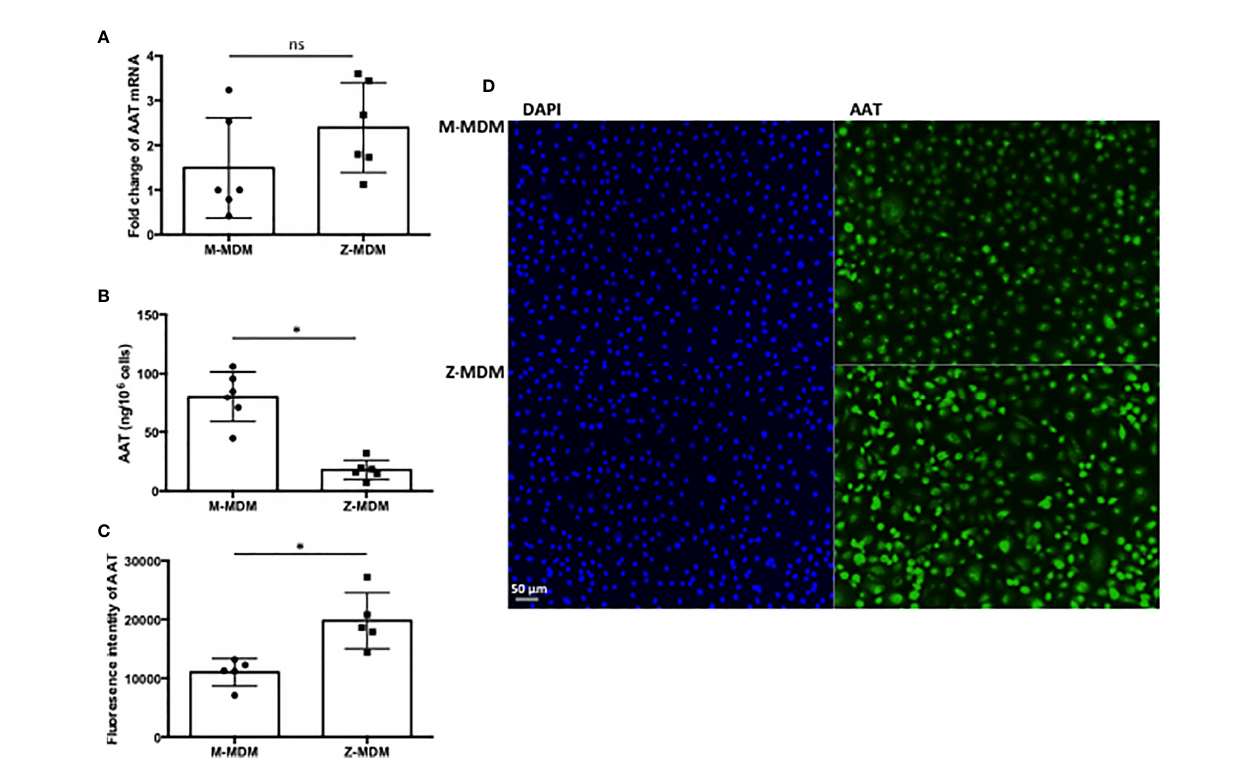
FIGURE 1 | AAT in M- and Z-MDMs. MDMs and their conditioned media were collected at day 7 of macrophage differentiation. AAT mRNA and protein levels are compared in M- and Z-MDMs (n=6). (A) The level of AAT mRNA was measured in M- and Z-MDMs using qRT-PCR. (B) The concentration of AAT was measured in conditioned media of M- and Z-MDMs using ELISA. (C, D) MDMs were immunostained for AAT (green) and the level of intracellular AAT was estimated based on the intensity of positive signal. 20x Images were taken using a fl uorescence microscope; bar 50 m m. ~2,000 cells, originating from three separate experiments, were evaluated for each MDM group. *Denotes statistical signi fi cance (p-value < 0.05) according to two-tailed Student ’ s